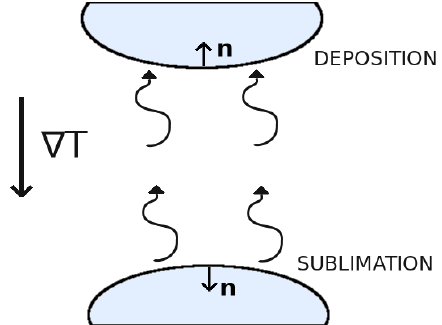
Figure A1. Schematic showing the normal vector n of deposition and sublimation surfaces. Ice crystals are represented in blue, and the thermal and vapor gradients are assumed to point